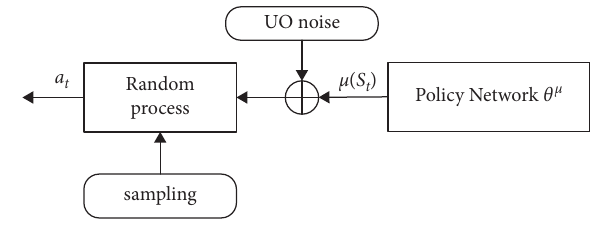
Figure 5: Improved DDPG action selection